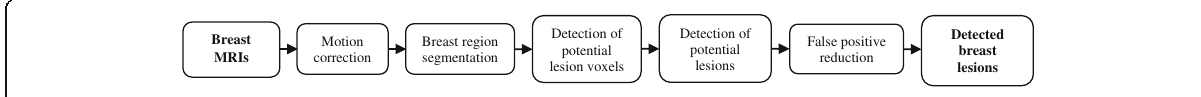
Fig. 1 Block diagram of the proposed CAD system for detection of breast lesions in DCE-MRI